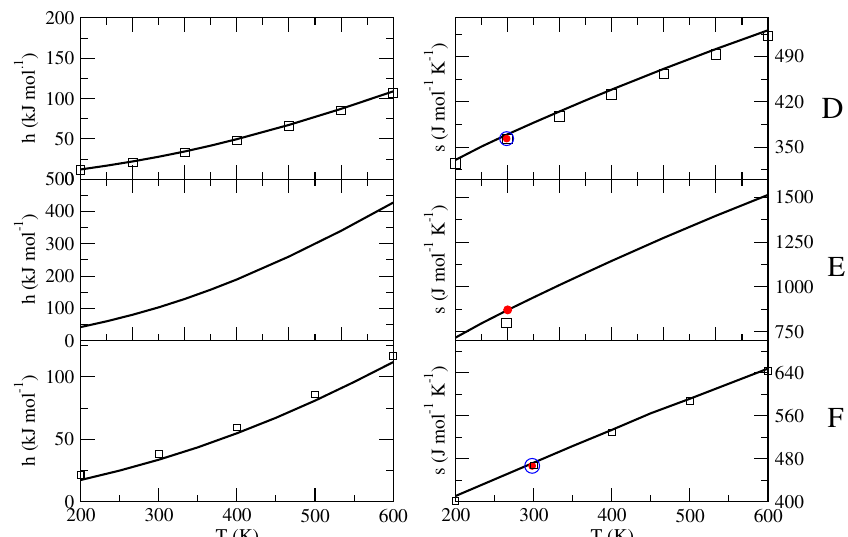
Figure 5. Standard-state molecular full enthalpy (with respect to h ref ( 0 ) ) and entropy as a function of the temperature for n-butanol ( D ), octadecane ( E ) and n-octane ( F ), as provided by our equation of state (solid line). The available experimental data found in the literature are reported with filled red circles: for ( D ) from reference [39]; for ( E ) from reference [5]; for ( F ) from references [40,41]. Values calculated with different theoretical-computational procedures are reported with squares and blue circles: for ( D ) from reference [38] (squares) and from reference [20] (blue circle); for ( F ) from reference [55] (squares) and from reference [5] (blue circle).